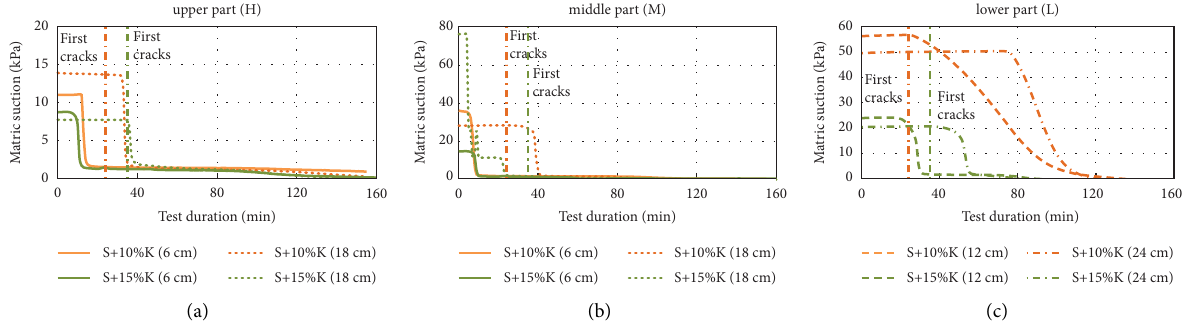
Figure 7: Matric suction in Test 2 (orange) and Test 3 (green) in (a) upper (H), (b) middle (M), and (c) lower (L) part of the slope at 6, 12, 18, and 24cm depth from the slope slope: sensor at 6 cm depth (L-6) with 0.146 m 3 /m 3 value of VWC from the one at 24 cm depth (L-24) with 0.211 m 3 /m 3 .